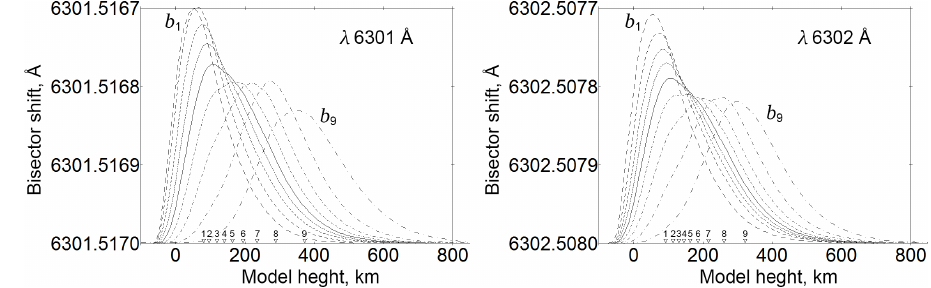
Figure 5. The response of the segments of bisectors b 1 − b 9 to LOS velocity variations at +0.5 km·s −1 in 5 km long “probe layer” and determina- tion of effective heights of response. Left: For 6301 line. Right: For 6302 line